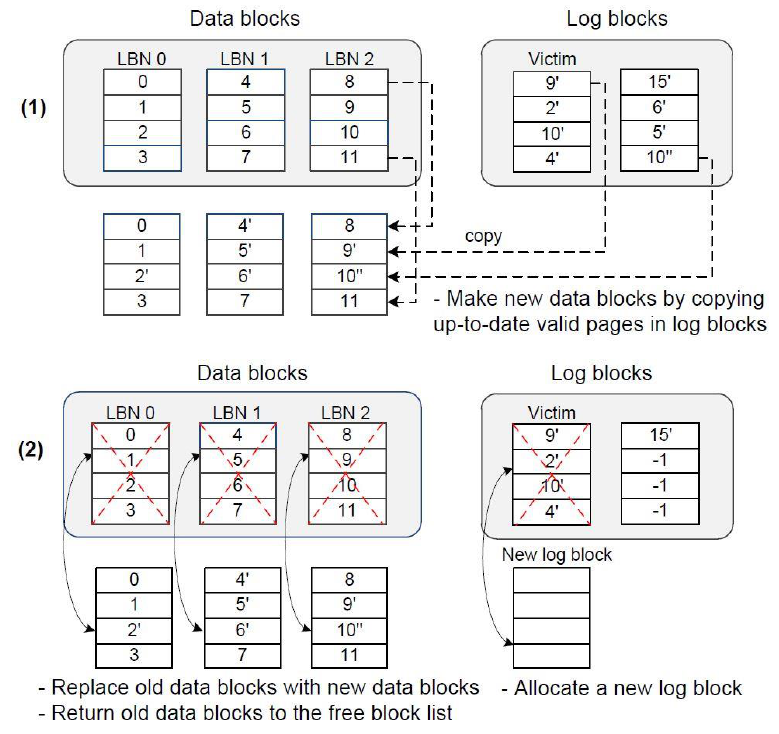
Figure 2. Merge operations in FAST.